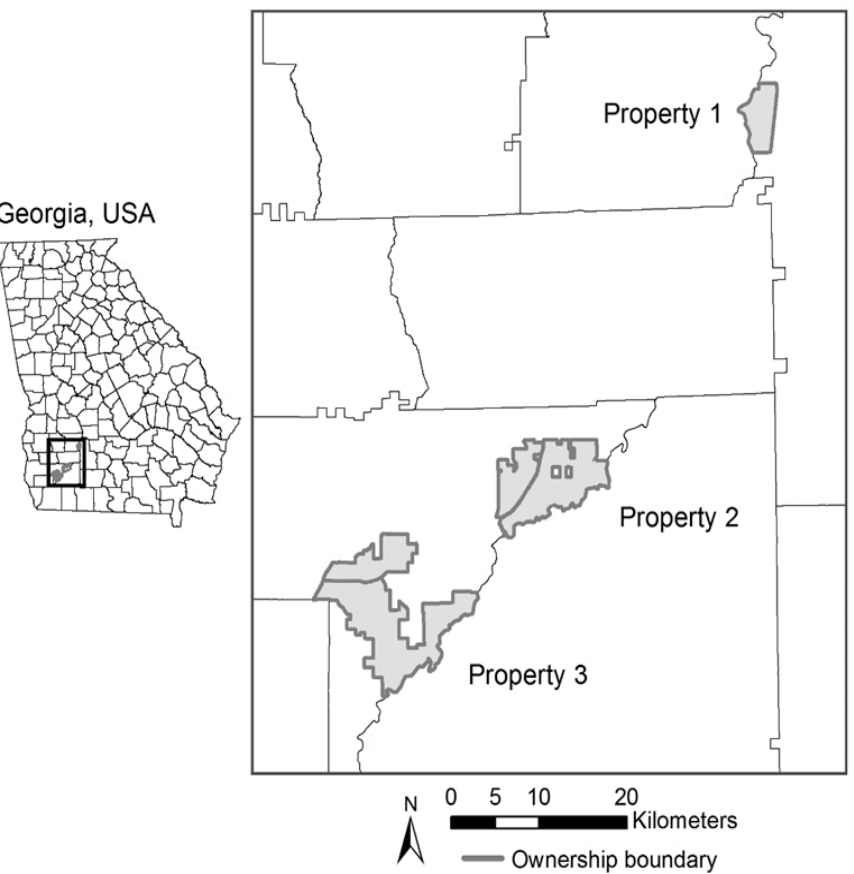
Figure 1. Properties in southwestern Georgia, USA, used to evaluate the effects of bait on male white-tailed deer ( Odocoileus virginianus ) resource selection in 2015–2016. Property one contains camera array site A, property two contains site B, and property three contains sites C and D.